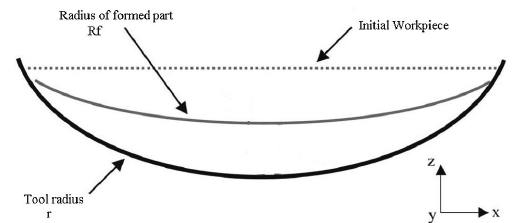
Figure 8. Spring back representation of CAF process - adapted from 10 .